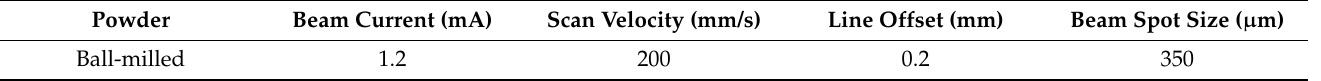
Table 3. Hatching (powder bed melting) test